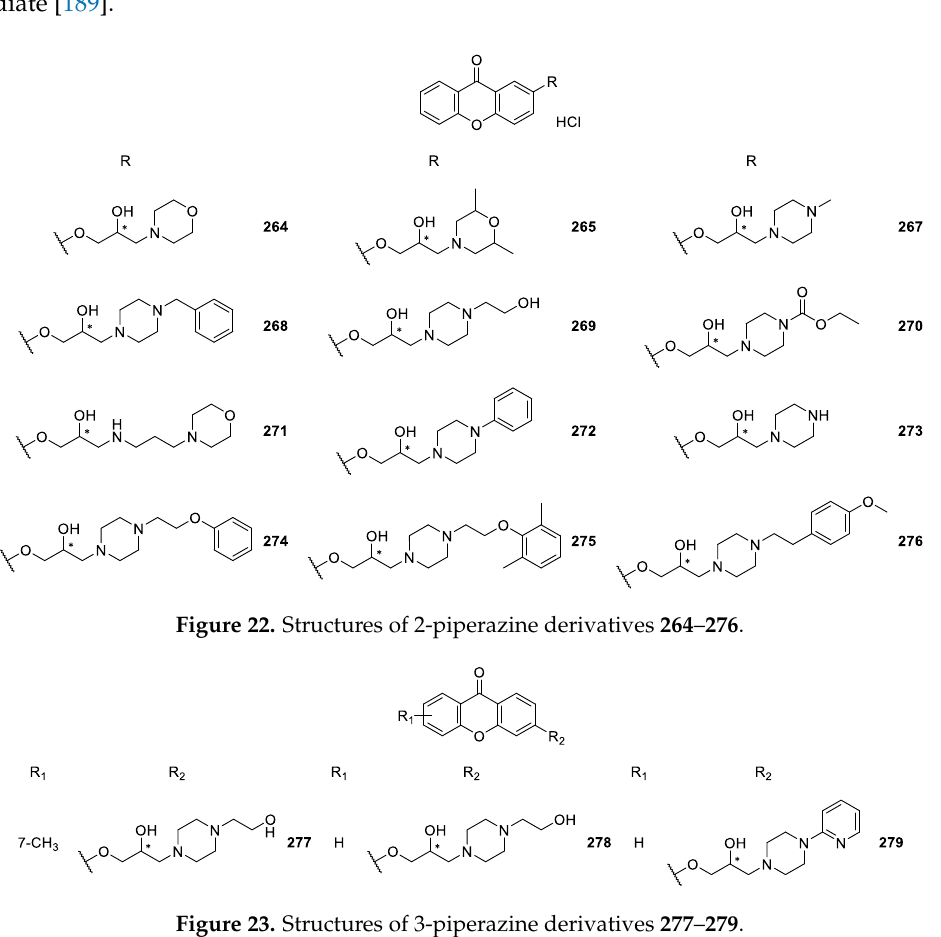
Figure 23. Structures of 3-piperazine derivatives 277 – 279 .